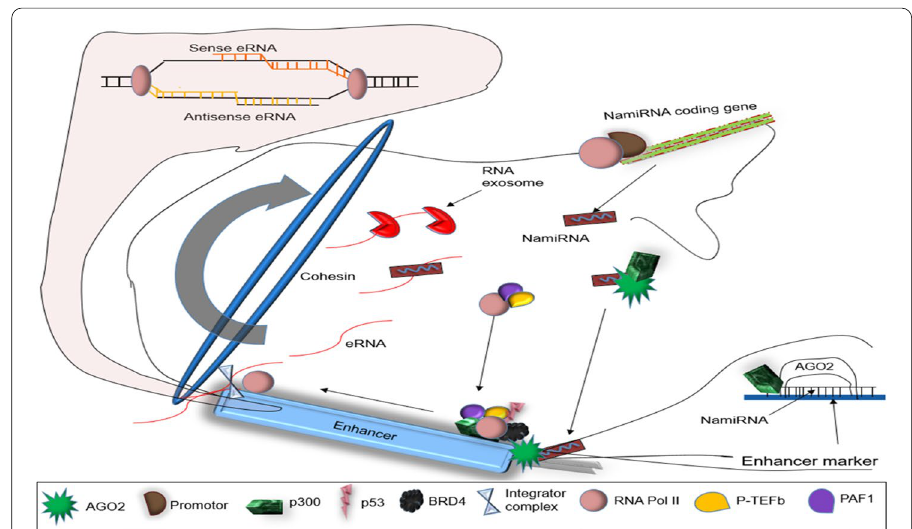
Fig. 1 Biogenesis of eRNA. NamiRNA forms a complex with nAGO2 and p300, which activate enhancer markers such as H3K27ac, H3K4me3, and H3K4me1 at active enhancers making the enhancer recognizable